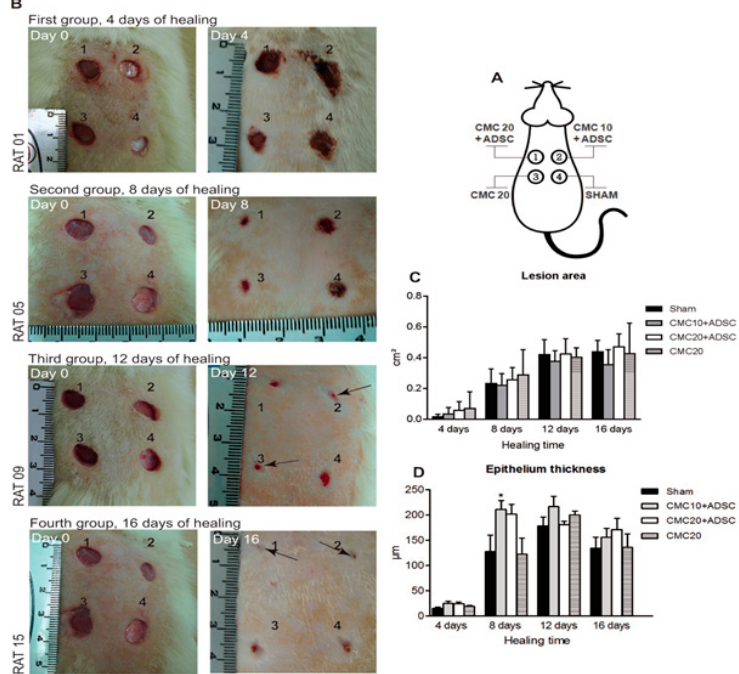
Figure 8. Progression of wound healing. ( A ) Wound model. Treated with four different approaches upper left ( 1 ) 100 µL of carboxymethylcellulose (CMC) 20 mg/mL + 26 × 10 6 of adipose derived stem cells (ADSCs); upper right ( 2 ) 100 µL CMC 10 mg/mL + 26 × 10 6 of ADSCs; bottom left ( 3 ) 100 µL of CMC 20 mg/mL; bottom right ( 4 ) Sham. ( B ) Animal, representative of each group showing wound closure, from day 0 to day 16. ( C ) Evaluation of the area of lesions and panel. ( D ) Determination of epithelium thickness. * p < 0.05. Reproduced under open access distribution license from [102].